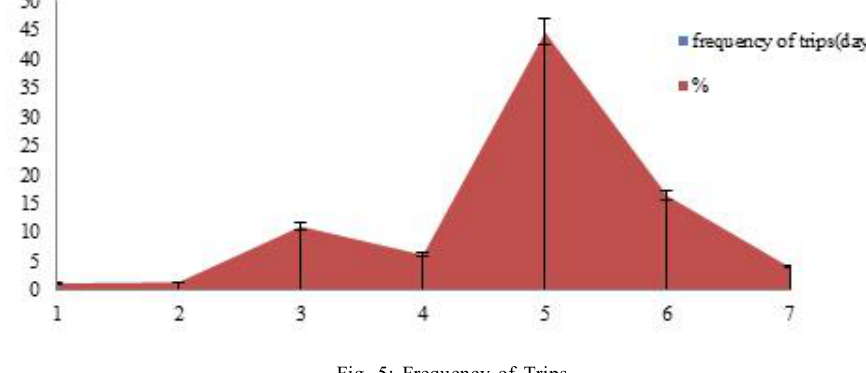
Fig. 5: Frequency of